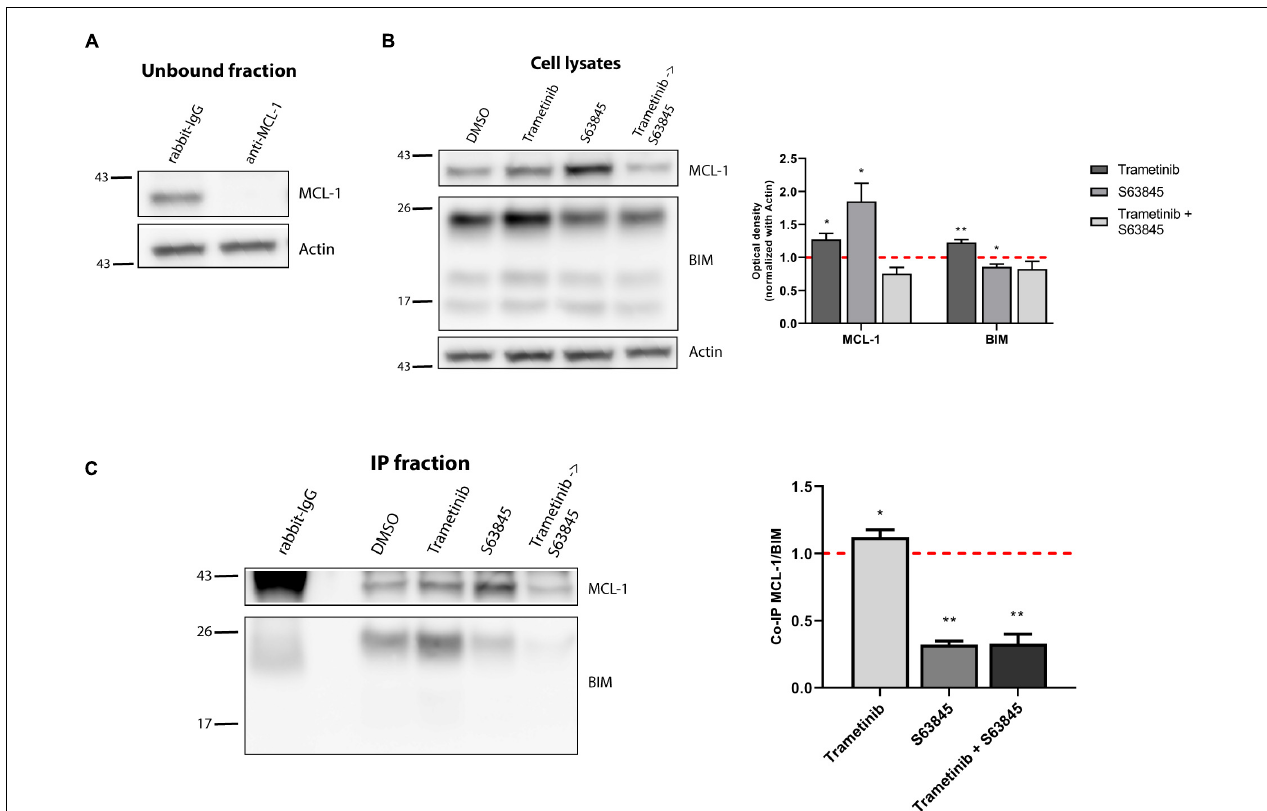
FIGURE 3 | Synergy of trametinib and S63845 in NALM-6 is explained by an increased interaction between MCL-1 and BIM. (A) Western blot analysis of the unbound fraction after MCL-1 immunoprecipitation. (B) Immunodetection of MCL-1 and BIM initial expression in cell lysates after 16 h of incubation with trametinib 100 nM, and 2 h of incubation with S63845 1,000 nM in the specified conditions. Quantification of optical density for each protein was normalized to actin and fold-change was calculated comparing to protein expression in the control condition. (C) Western blot of the immunoprecipitated fraction was used to study the interaction between MCL-1 and BIM after treatment with trametinib 100 nM and 2 h with S63845 1,000 nM. To quantify this binding, BIM optical density was normalized to MCL-1 optical density and fold-change was calculated comparing to protein expression in the control condition. All results are expressed as the mean ± SEM of at least three biologically independent replicates. Statistical significance was calculated using Student’s t -test compared to control condition and considering * p < 0.05 and ** p < 0.01.